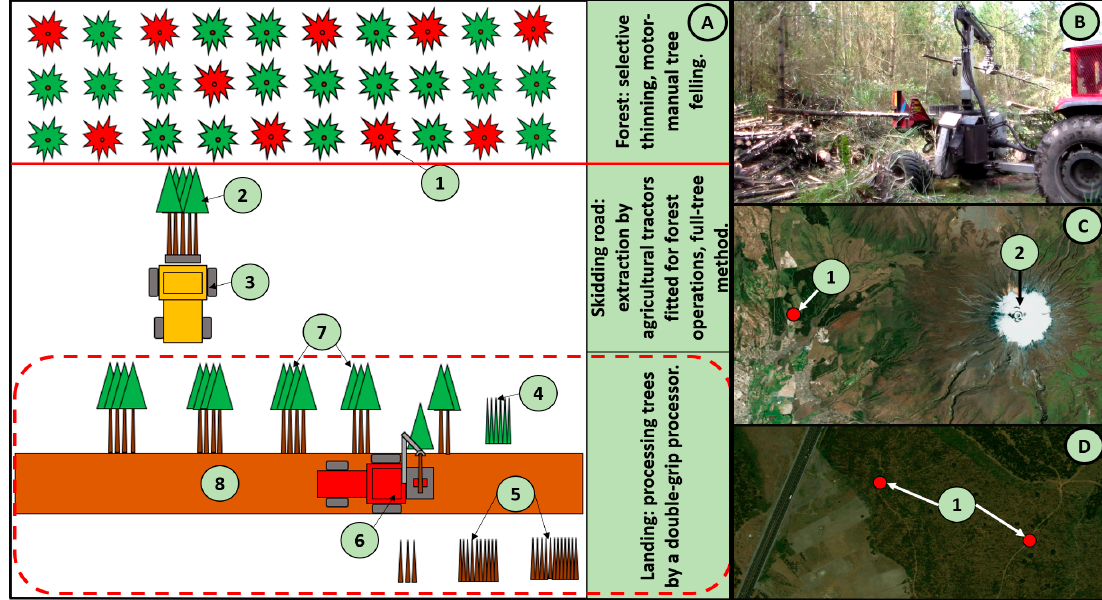
Figure 1. Study location, description of the harvesting system and study’s scope. Legend: A—harvesting system and operation taken into study: 1—tree removed by selective thinning, 2—bunch of trees skidded to landing, 3—farm tractor used for skidding, 4—pile of tops and limbs, 5—wood pile, 6—double-grip processor, 7—bunches of trees to be processed, 8—road; B—HYPRO 775 double-grip processor observed in this study; C—general study location: 1—location of the surveyed operations, 2—Cotopaxi volcano; D—locations of operation: 1—points of observation (landings).